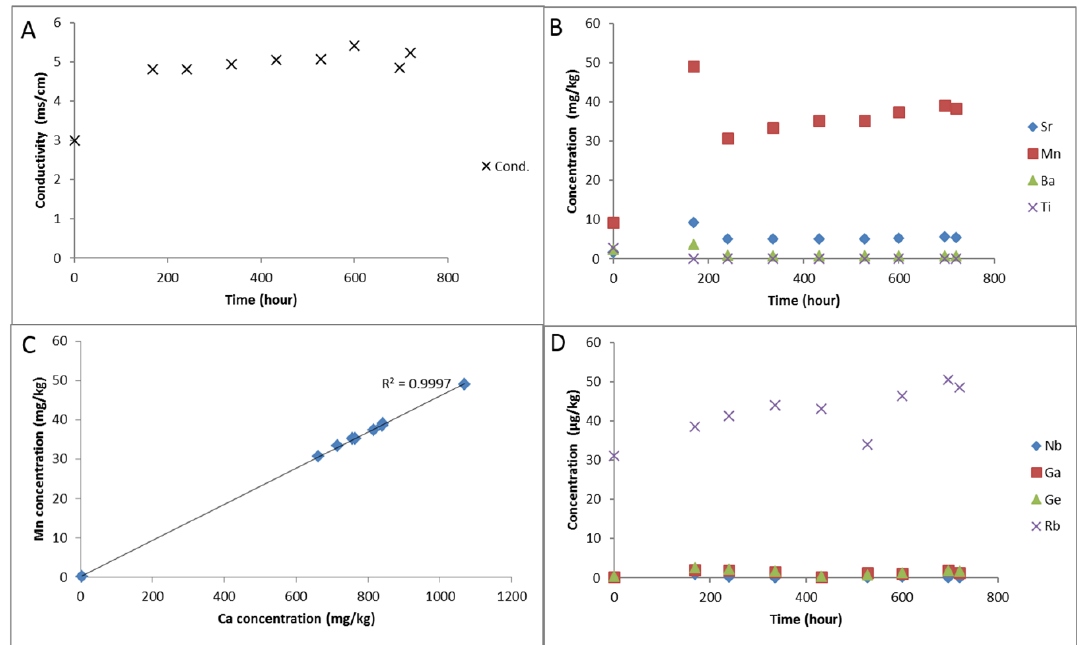
Figure 7. Experimental water chemistry during reaction of the cap-rock ( A ) solution electrical conductivity; ( B ) Dissolved concentrations of Sr, Mn, Ba and Ti; ( C ) correlation of dissolved Ca and Mn; ( D ) Concentrations of dissolved Nb, Ga, Ge, and Rb.